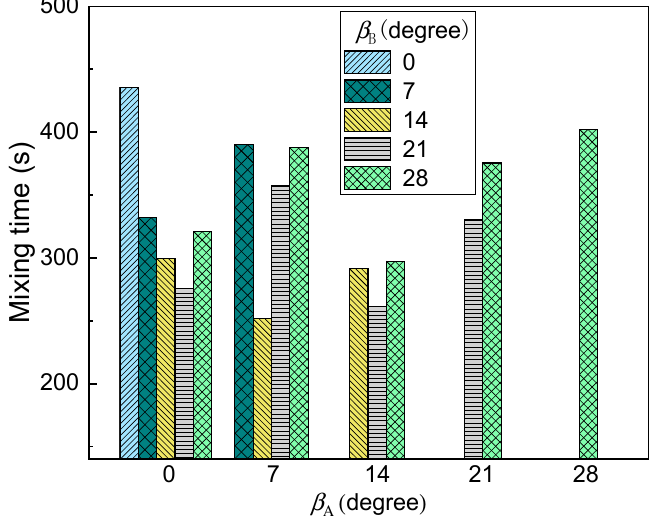
Figure 10. E ff ect of di ff erent nozzle arrangements on the predicted mixing time in the Figure 10. Effect of different nozzle arrangements on the predicted mixing time in the bath.